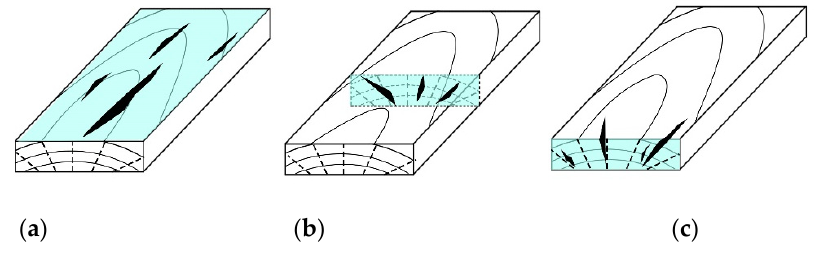
Figure 1. ( a ) Surface checks, ( b ) internal checks, ( c ) end checks.